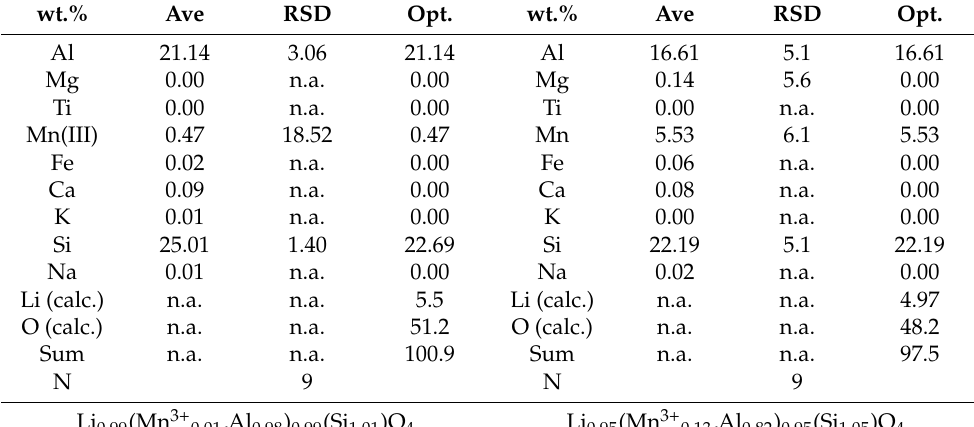
Table 2. Example of a Mn-ELAS determined in the Mn-rich material. Ave: Arithmetic average, RSD: relative standard deviation (n) of repeats, Opt.: Optimized composition of ELAS using virtual compounds, N: number of